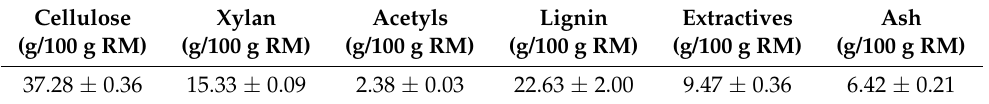
Table 2. Cynara cardunculus L. composition before the OV pretreatment.